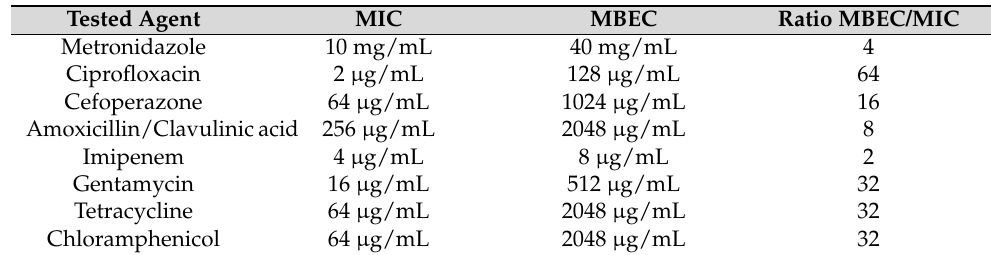
Table 1. Metronidazole and Antibiotics MIC and MBEC to P. mirabilis isolated from diabetic foot. Tested Agent MIC MBEC Ratio MBEC/MIC Metronidazole 10 mg/mL 40 mg/mL 4 Ciprofloxacin 2 µ g/mL 128 µ g/mL 64 Cefoperazone 64 µ g/mL 1024 µ